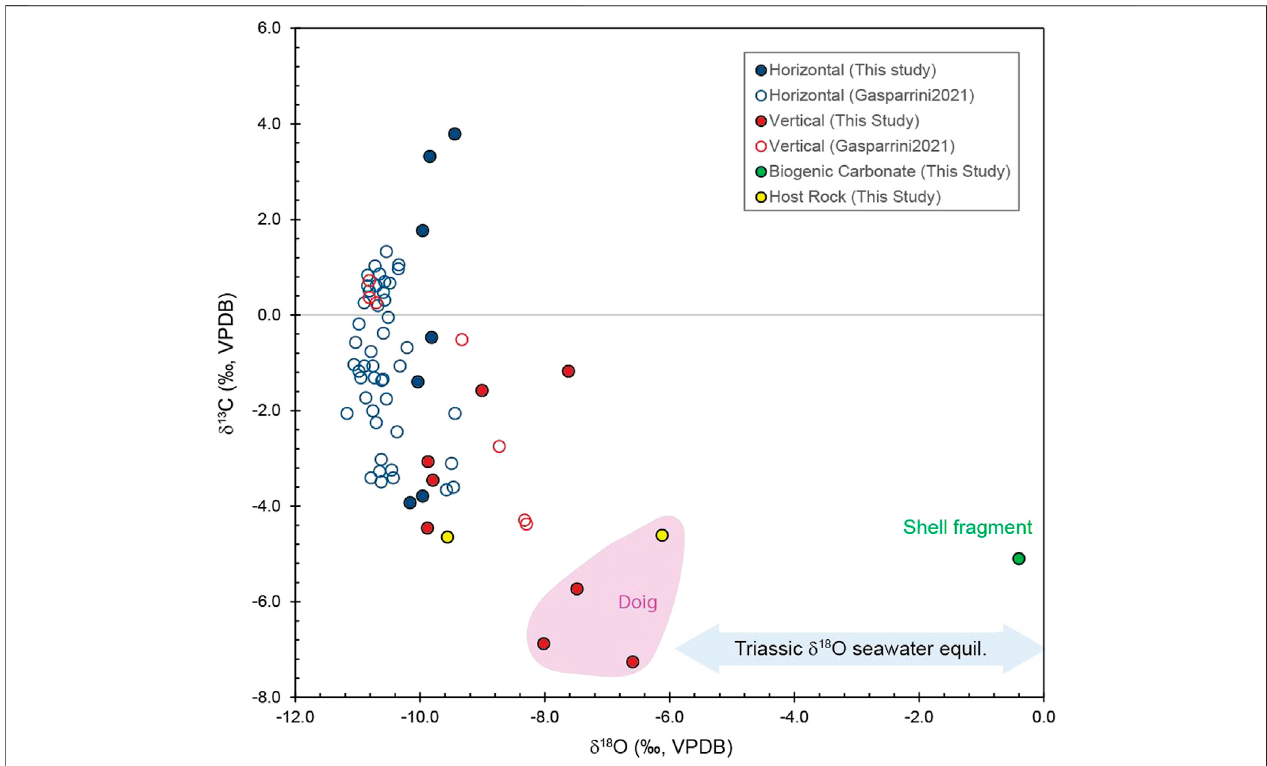
FIGURE8| Crossplotof δ 13 Cand δ 18 Ofromstableisotopeanalysisofdifferentcarbonatephases.FracturecalcitedatafromthisstudyandGasparrinietal.,(2021). Biogenic carbonate (shell fragment) plots close to predicted Triassic seawater δ 18 O values. Vertical and horizontal (bedding-plane parallel) fracture calcite and host rock dolomite exhibit δ 18 O values 6 – 10 ‰ lower then predicted if derived from Triassic seawater.